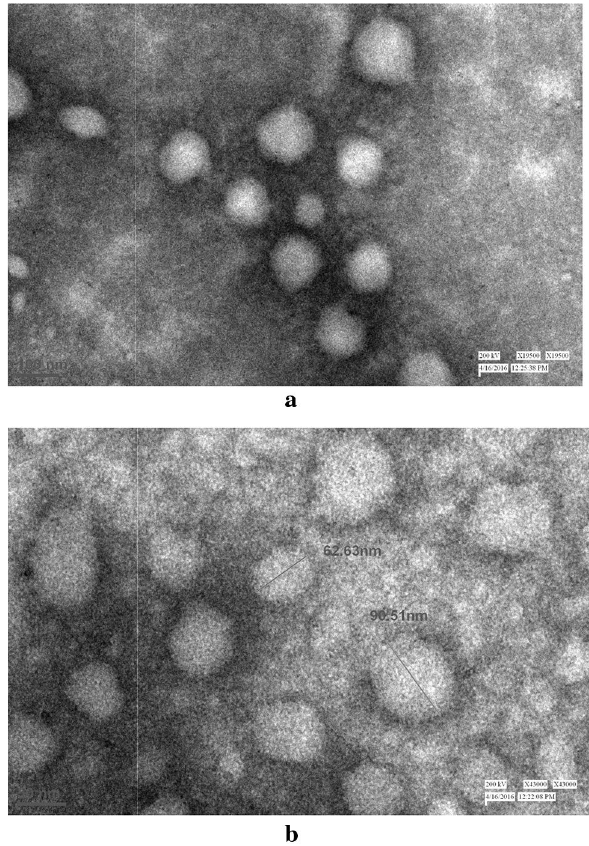
Figure 5. ( a ) TEM image for an empty influenza virosomes-showed the negatively stained sample confirms the formation of empty influenza A/H1N1 virosome particles, hollow from the interior with their reconstituted